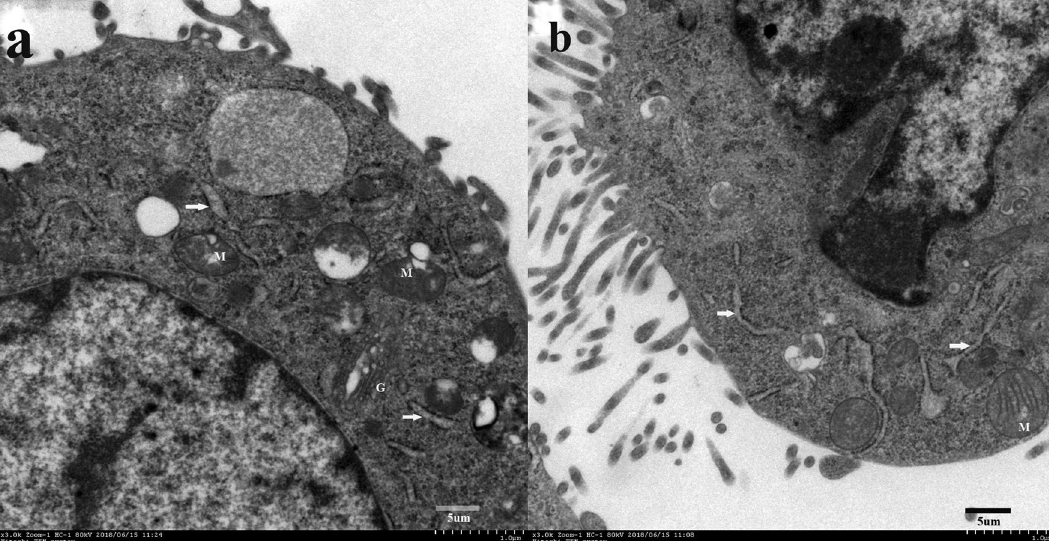
Figure 4. Transmission electron microscopy of V79 cells cultured in the DUGL ( a ) or AGL ( b ) 3,000 × White arrows: endoplasmic reticulum; M mitochondria, G Golgi body, AGL above-ground laboratory, DUGL deep underground